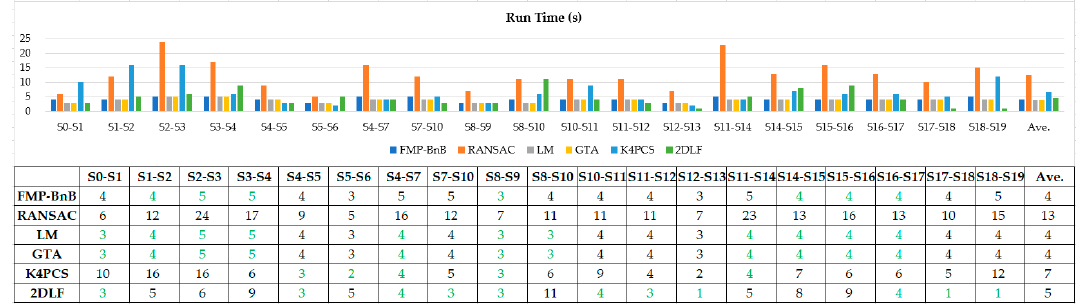
Figure 12. Run time to register point cloud pairs from dataset CB (the most time-efficient method for each pair is colored in green).